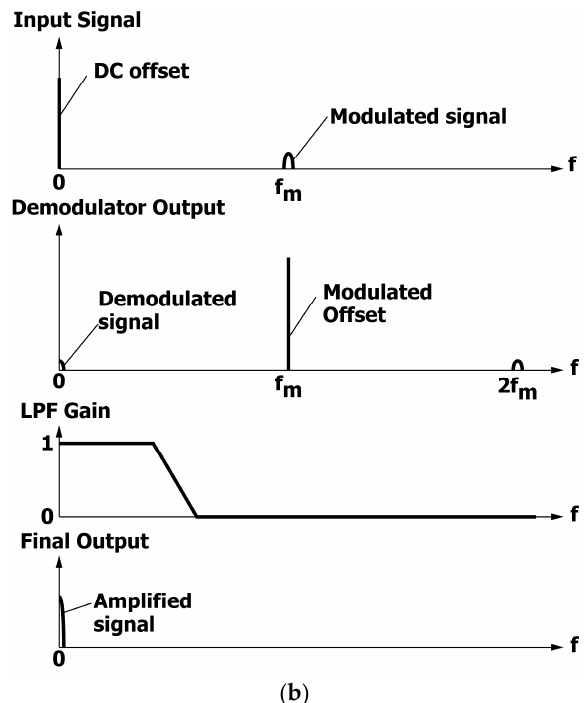
Figure 3. Lock-in amplifier for detecting small signal with large offset: ( a ) block diagram; ( b ) operation in frequency domain.